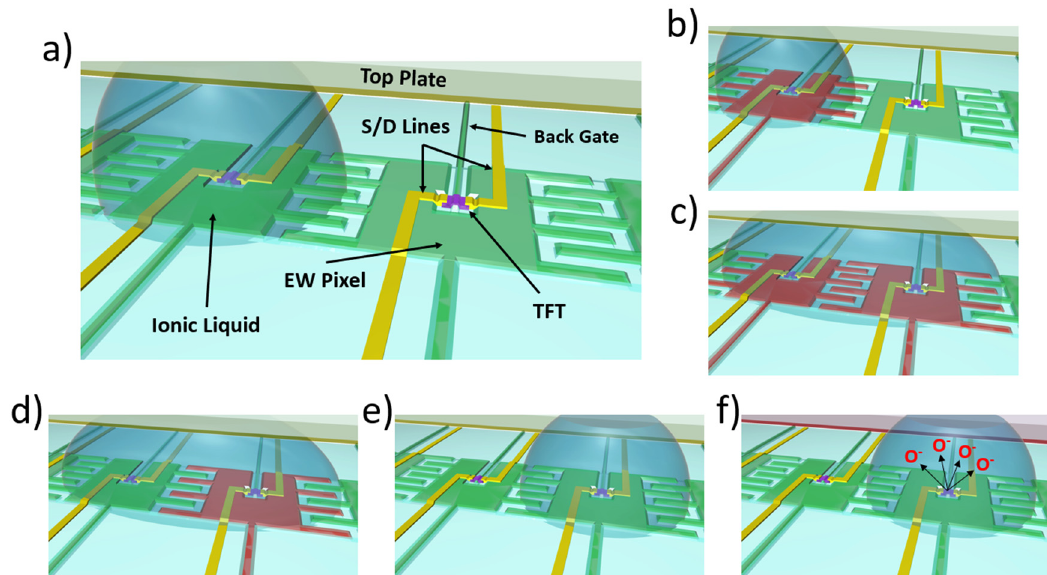
Figure 1. ( a ) Schematic of programmable electrofluidic neuromorphic device, with critical components labeled. See Supplementary Materials Figure S1 for a detailed and labeled 2D cross-section of device. ( b – e ) Schematic illustration demonstrating the electrofluidic control of the ionic liquid (IL). In ( b ), the ionic liquid is present initially over the left pixel and is electrofluidically transferred to the neighboring right pixel by initially actuating the left pixel, which decreases the surface energy and causes the IL to spread. Next, ( c ) the neighboring right pixel is actuated, which causes the IL to selectively spread to this pixel. The left pixel is then turned off ( d ), which increases the surface energy, and thus the ionic liquid migrates over to the right pixel. After movement to this pixel, the right pixel is then turned off ( e ), which completes the cycle. Short-term plasticity is realized when a transistor is measured with IL present on the pixel. Long-term plasticity is realized by applying a bias on the ionic liquid via the top plate ( f ), which electrochemically alters the composition of the material by extracting oxygen ions, permanently altering its electrical resistance (see Supplementary Materials Video S1 for full video).